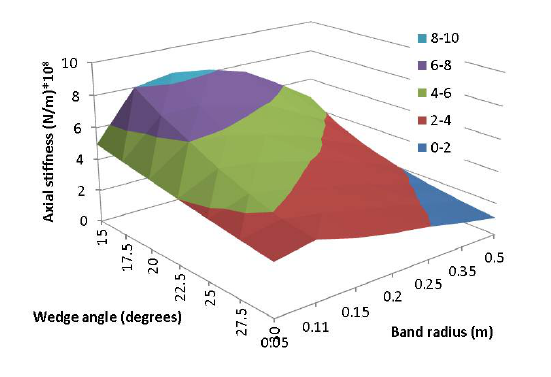
Figure 18: Axial stiffness for different band size and a range of wedge angle (theoretical model).